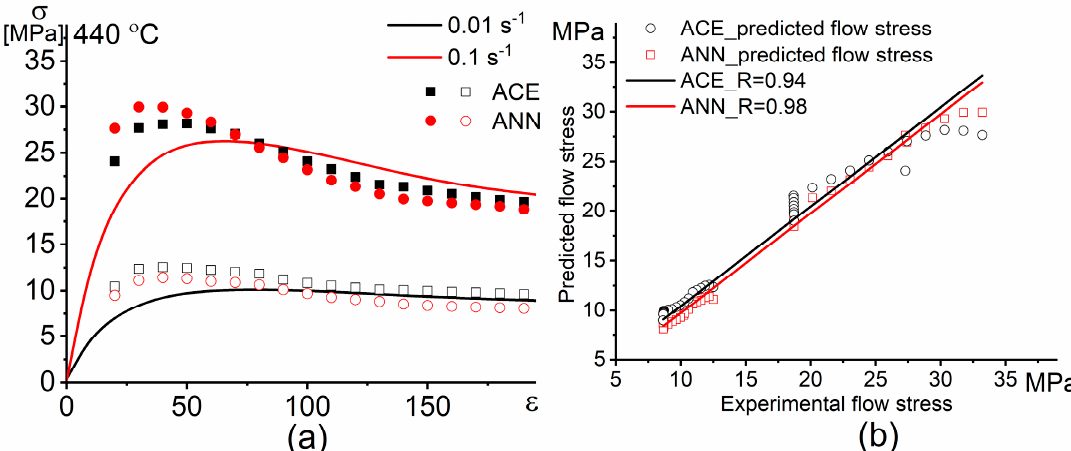
Figure 11. ( a ) Dependence and ( b ) correlation of the experimental and the predicted flow stress obtained by the constitutive model (CE) and the ANN model vs. strain.